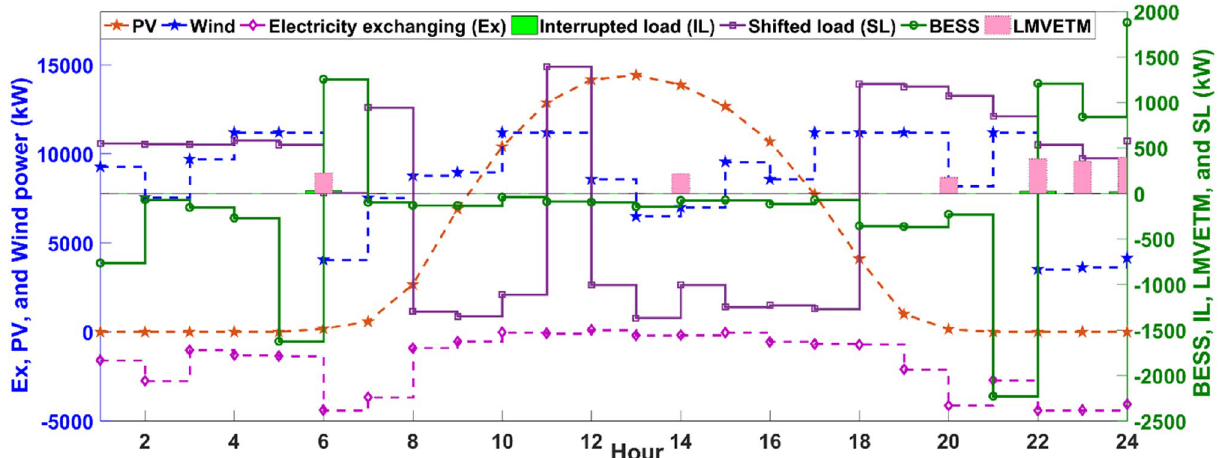
Figure 3. Optimal scheduling of EPS units. It provides a comprehensive overview of how EPS systems are optimally operated in the complex energy structure.